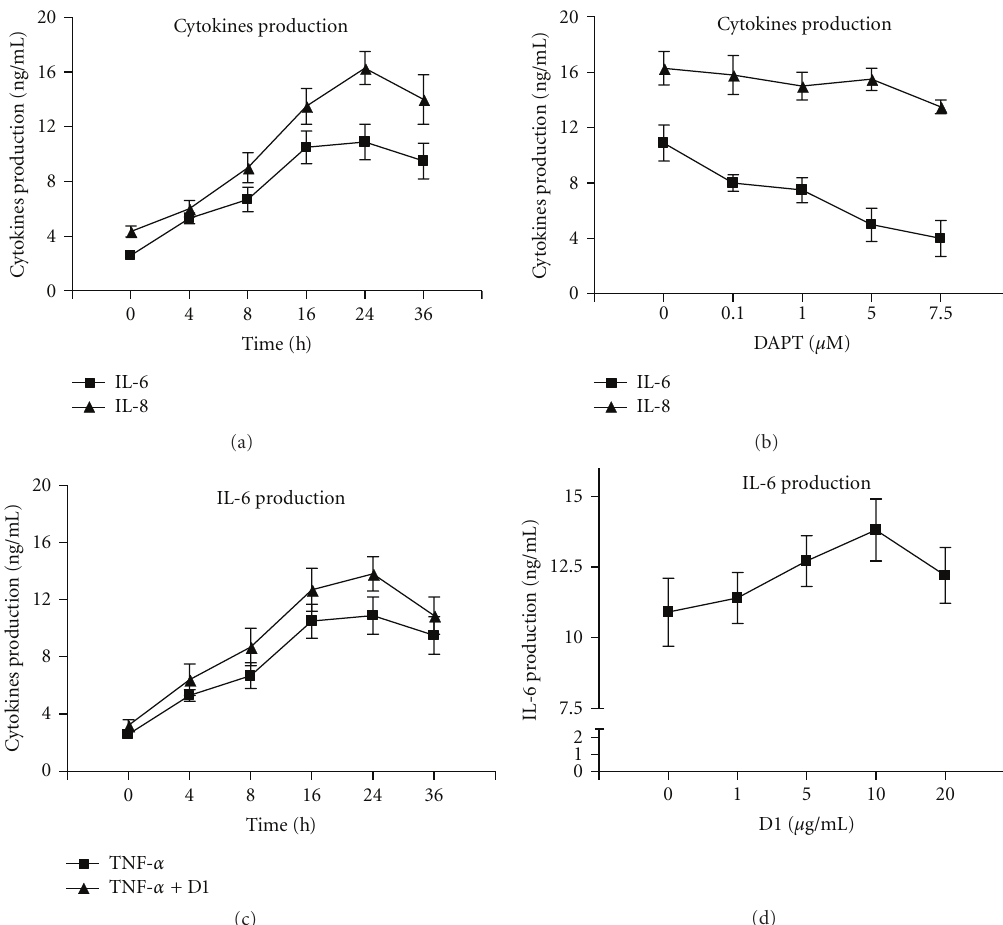
Figure 2: Notch activity contributes to TNF- α -induced IL-6 production of FLSs from RA. (a) FLSs from 4 RA patients were cultured in the presence of TNF- α (10ng/mL) for 0, 4, 8, 16, 24, or 36h, and then measured the levels of supernatant IL-6 and IL-8 by ELISA; (b) RA FLSs were cultured in the presence of TNF- α (10 ng/mL) in addition to the indicated concentration of DAPT (Notch signaling blocking reagent) for 24h. Supernatant IL-6 and IL-8 were determined by ELISA; (c) RA FLSs were cultured in the presence of TNF- α (10ng/mL) in addition to Delta-like 1 fusion protein (10 μ g/mL) for indicated times. Supernatant IL-6 was determined by ELISA; (d) RA FLSs were cultured in the presence of TNF- α (10ng/mL) in addition to indicated concentrations of Delta-like 1 fusion protein for 24h. Supernatant IL-6 was determined by ELISA. Values are the mean ±